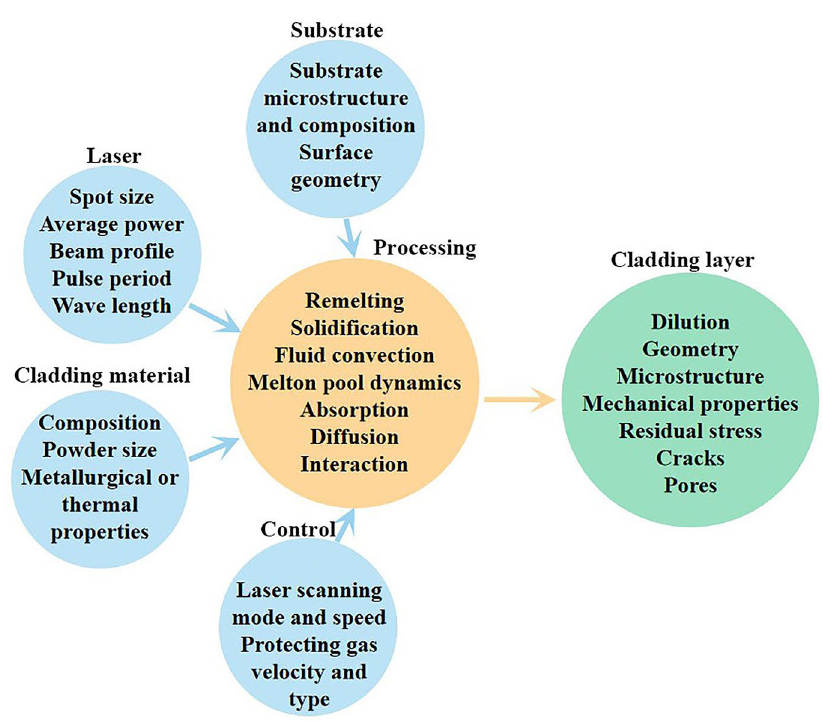
Figure 4. Schematic diagram showing the influence factors during LC processing.